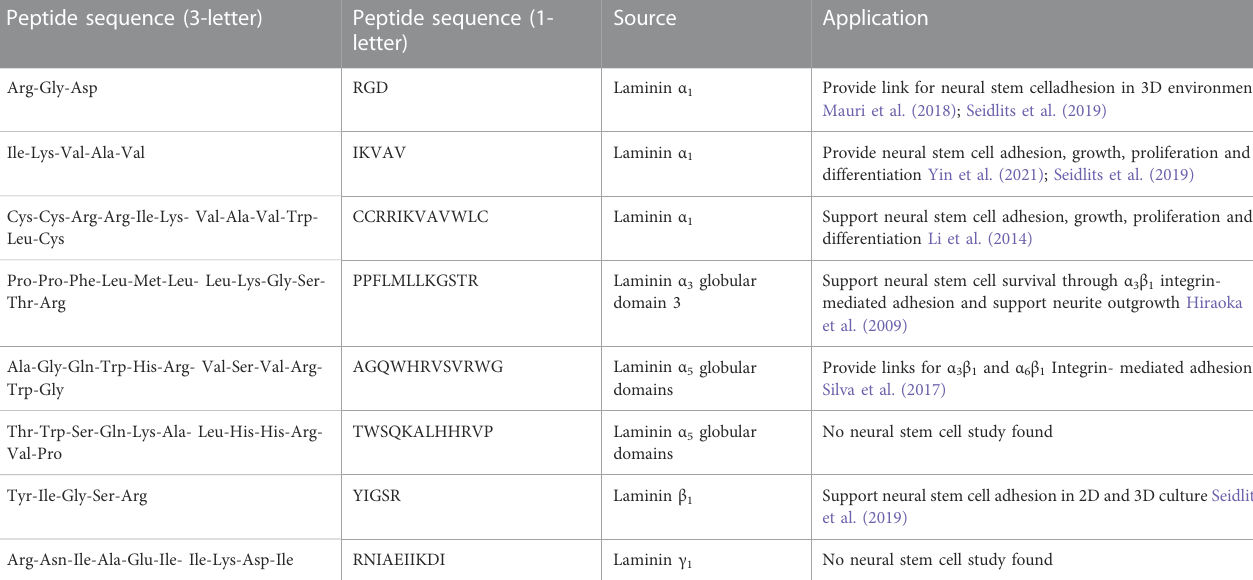
TABLE 3 List of laminin-derived peptides that are commonly used in mimicking neural stem cell niche. Peptide sequence